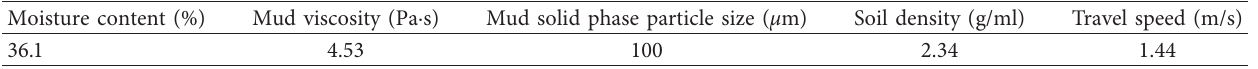
Table 1: Mud model